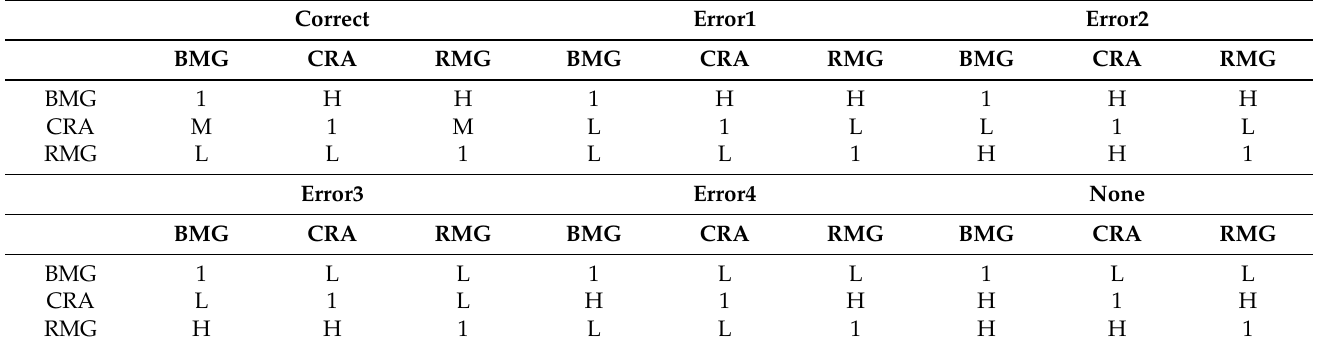
Table 5. Different cost matrix configurations. Here, there is one correct configuration from domain